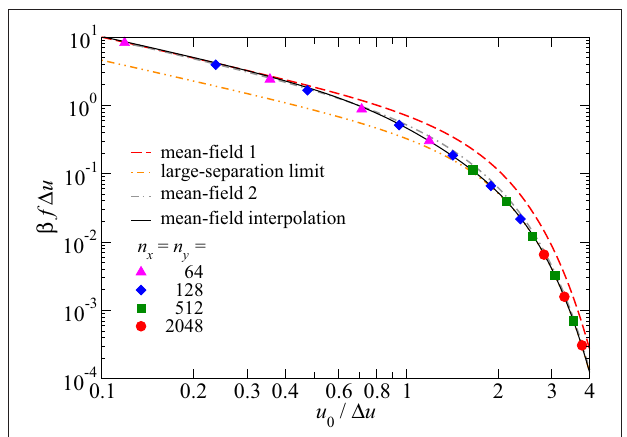
FIGURE 4 | Mean force f , in units of 1 /β1 u , as a function of normalized mean separation u 0 /1 u , where 1 u represents the height standard deviation of a surface atom in the absence of a counterface.